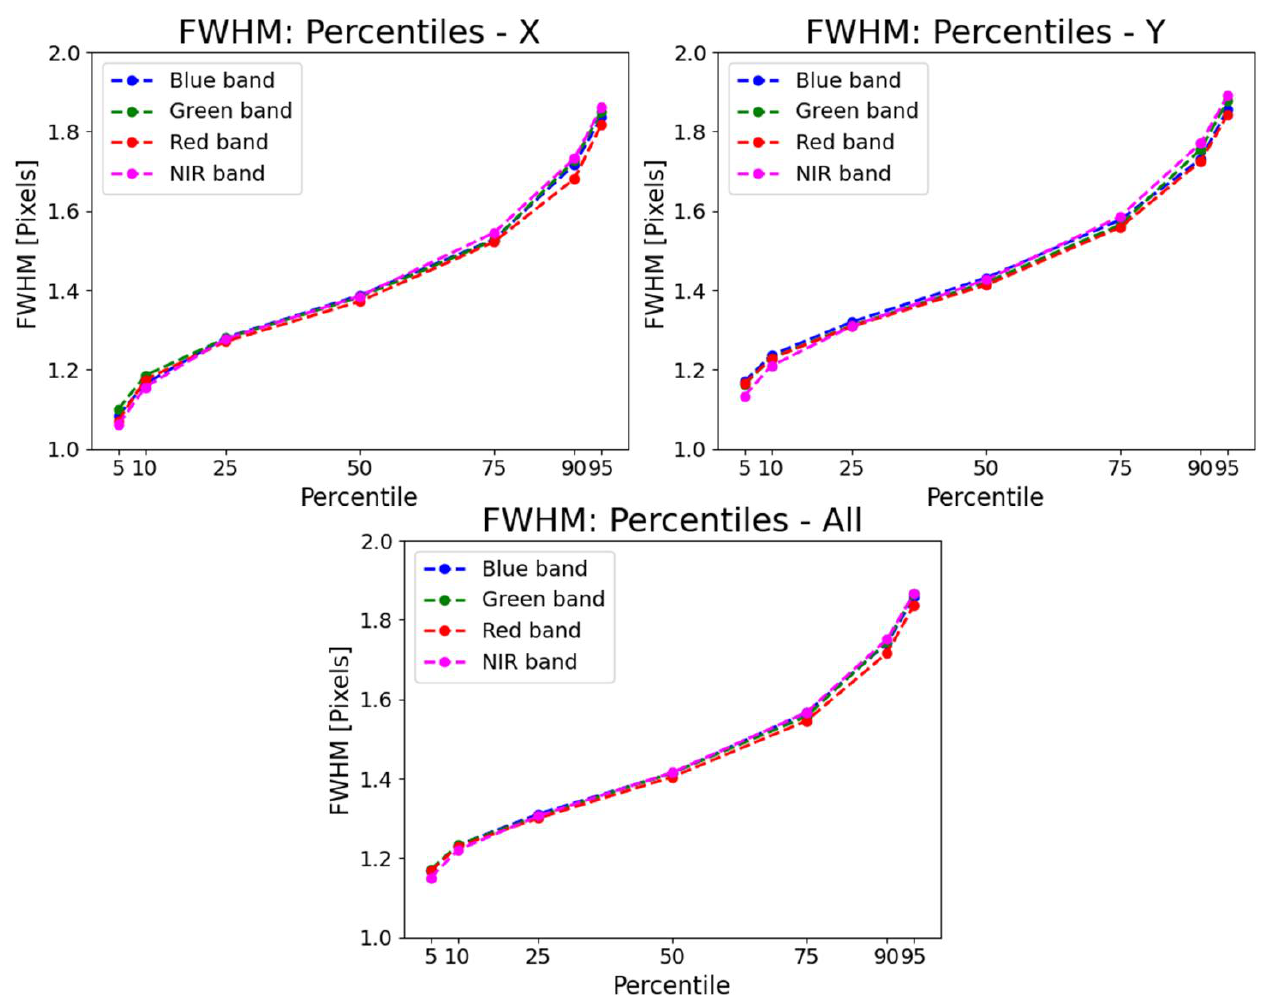
Figure 9. In the figure are shown the different percentile of FWHM values obtained from the L1T analysis. The data are displayed for all the spectral bands and for all the categories of sampling direction: “X”, “Y”, and “All”.